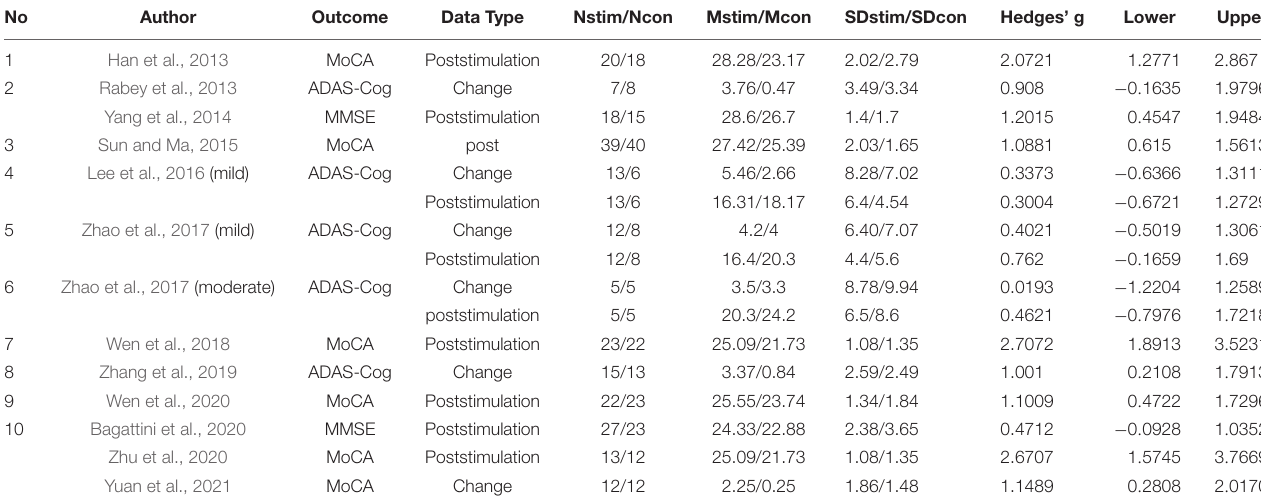
TABLE 3 | Summary of the effect sizes for global cognitive